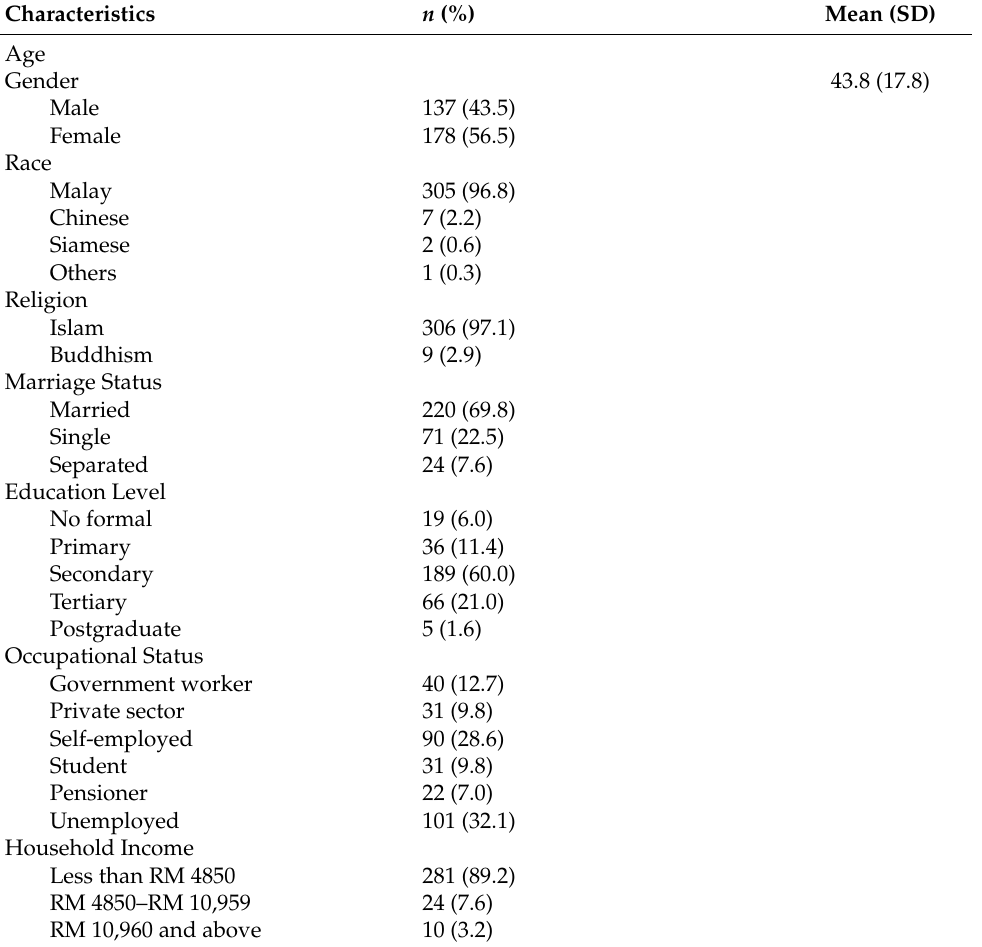
Table 1. Sociodemographic characteristics of inpatients ( n =